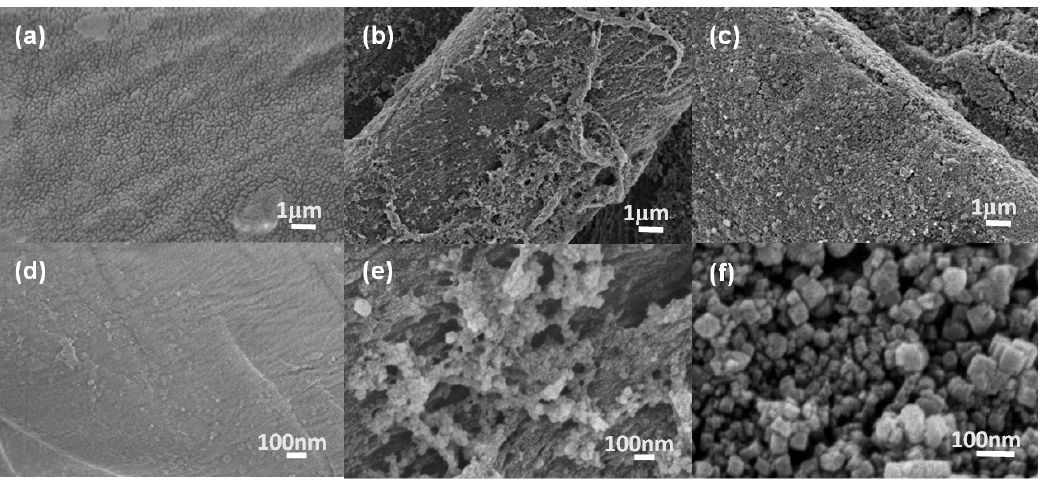
Figure 3. SEM images of CFs ( a , d ), PPy@CFs ( b , e ), and PB/PPy@CFs ( c , f ) at 20 kx and 150 kx mag- nifications.